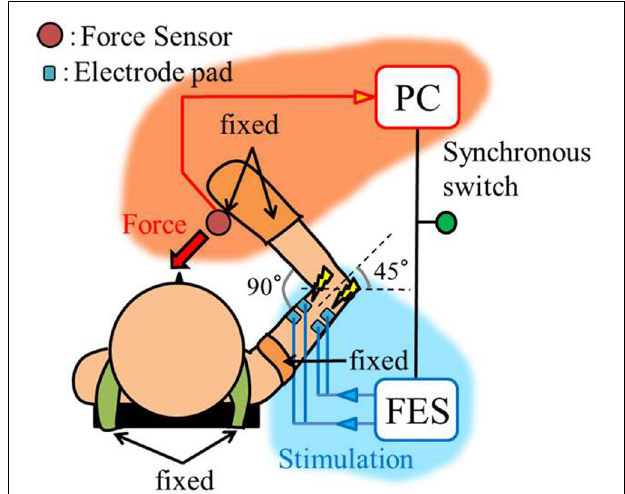
FIGURE 1 | Experimental setup, top view.